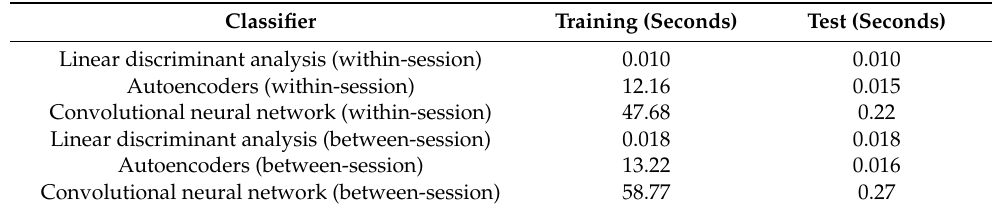
Table 10. The computational time of the training and test data for within- and between-session calibration. In the within-session scenario, the training data consisted of 828 data windows, and the test data consisted of 198 test windows. For the between-session scenario, the training and test data consisted of 1026 data